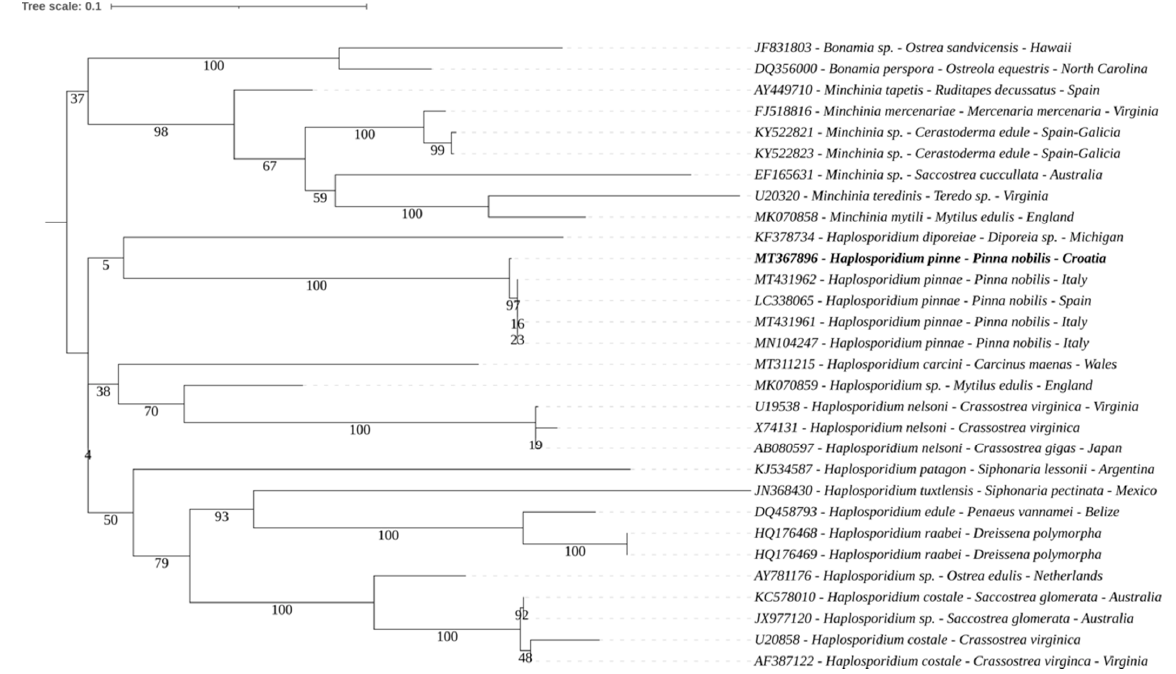
Figure 8. Maximum likelihood phylogenetic tree for haplosporidians. The numbers on the branches represent bootstrap values.